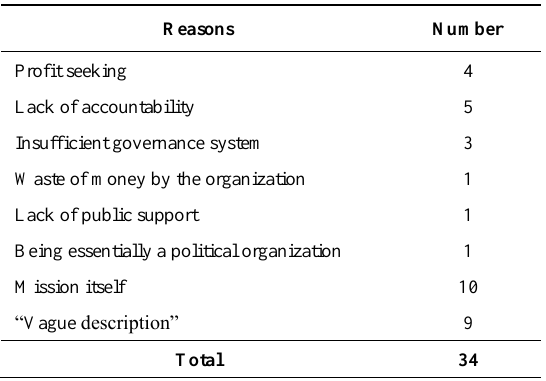
Table 3. Descriptions on